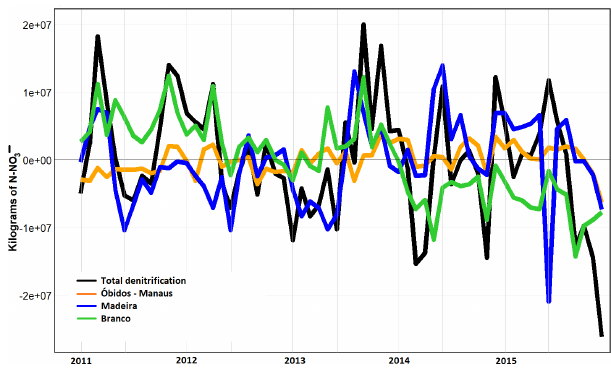
Figure 8. Monthly anomalies at the basin and main floodplains scale for denitrification throughout the period